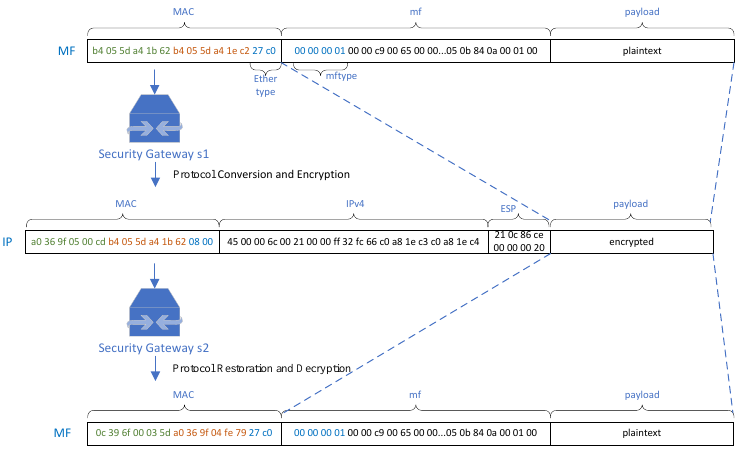
Figure 11. The processing flow of a MF packet.